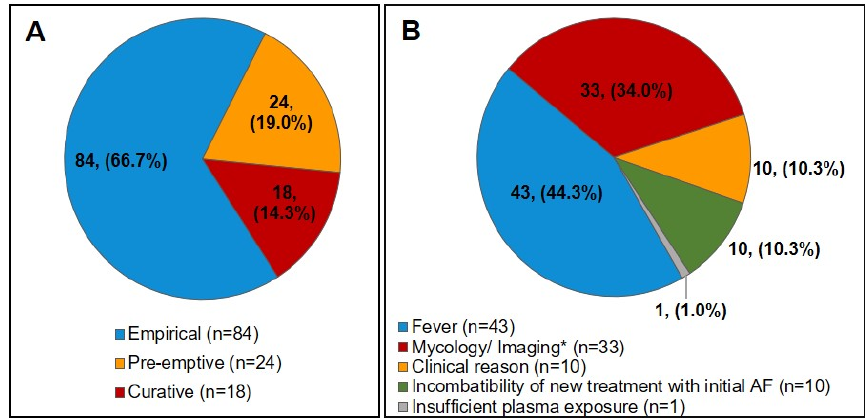
Figure 3. ( A ) Treatment introduced after the end of the antifungal prophylactic treatment; ( B ) Reasons for introduction of a non-prophylactic treatment; * Mycology and imaging tests include: blood culture,